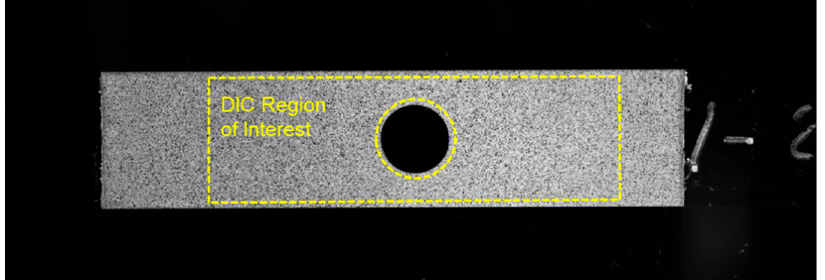
Figure 3. An example of speckle pattern created on the surface of an OHC test specimen and region of interest for digital image correlation (DIC) analysis.